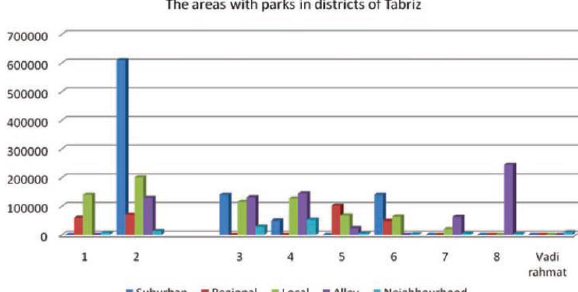
Figure 25. The Areas with Parks in Districts of Tabriz (Abizadeh and Zali, 2013).